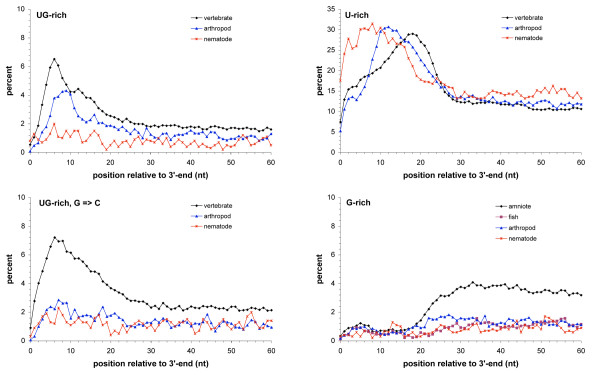
Combined positional frequencies of selected groups of tetramers downstream of the 3'-processing site for ten metazoan species. A: Proximal UG-rich element (including UGUG and GUGU), B: distal U-rich element (including all single base substitutions of UUUU), C: alternative proximal UG-rich element with G to C transversion (including UCUG, CUGU, UGUC, and GUCU) and D: G rich element (including GGGG, GGGA, GGAG, GAGG, and AGGG). In all panels, the vertical axis is the frequency of occurrence of any of the grouped tetramers at the position indicated along the horizontal axis.